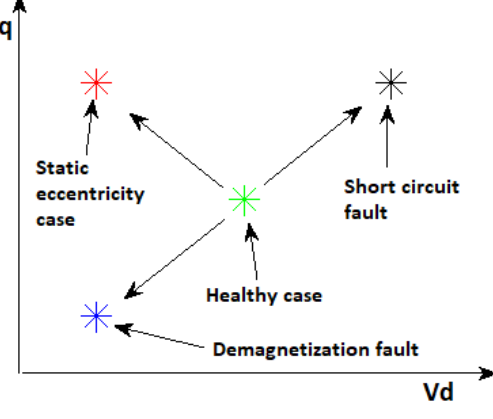
Figure 1. Shift in V d / V q under different faults [24].